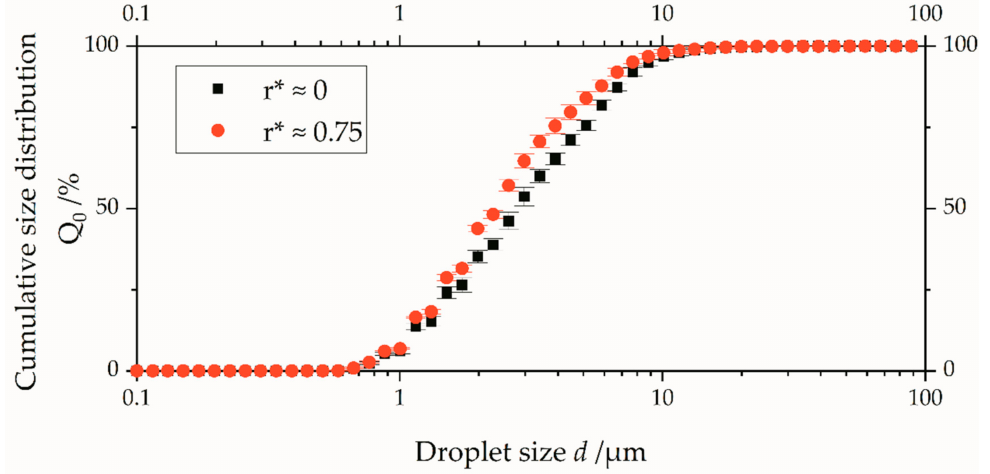
Figure 27. Droplet size distribution, on the meso scale, of a processed emulsion as a function of the droplet trajectory, at Re = 2000 and a pre-emulsion size of d 0 = ( 208 ± 8 ) µ m. The monodisperse emulsion is broken into droplets within the range of 0.6 µ m < d < 20 µ m for both trajectories. A mono modal droplet size distribution is found for both trajectories. Droplets which travel on a trajectory close to the wall result in significantly smaller secondary droplets compared to droplets which travel on the center axis of the orifice. An average droplet size of d 50,0 = 2.29 µ m is determined for droplets on the trajectory close to the wall, while the secondary droplet size is rather d 50,0 = 2.74 µ m on the center axis